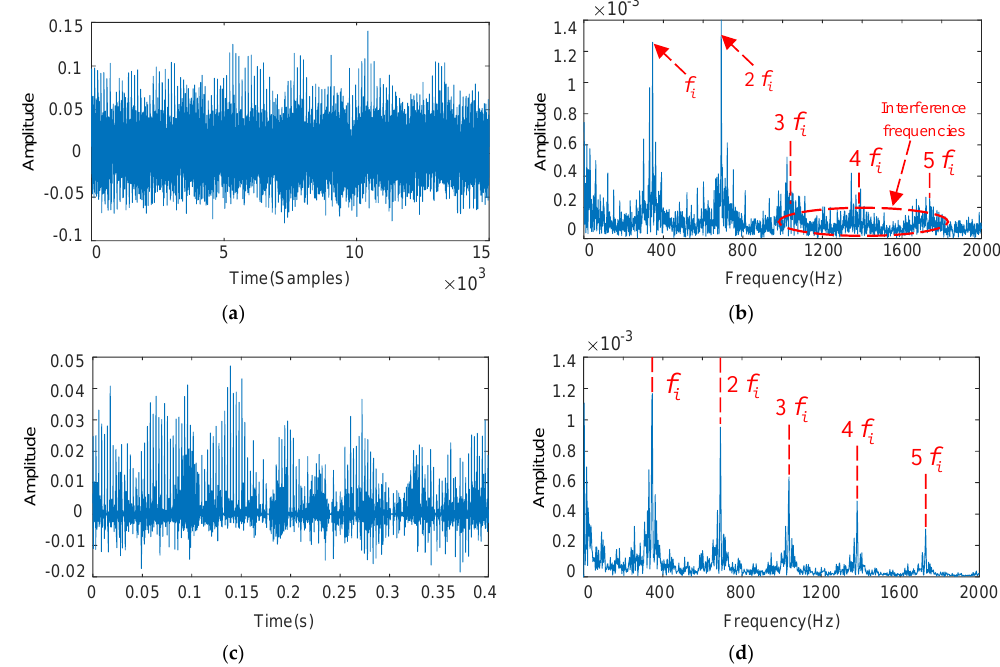
Figure 9. The decoupled bearing inner ring vibration signal and its frequency spectrum: deconvo- lution results of MOMEDA: filtered time domain waveforms and their frequency spectrum ( a , b ); Results obtained by MOMEDA and optimized RSSD: time domain waveforms and their frequency spectrum ( c , d ). T is set with the fault characteristic frequency of the The deconvolution period b bearing rollers, and the results as shown in Figure 10. The envelope spectrum in Figure f , 3 f , and 4 f are not apparent and the 10b shows that the fault feature frequencies 2 b b b Q = 8.0, H Q = 2.0, r = 3.5, r = 3.5, and the low-resonance components obtained by decompo- L H L